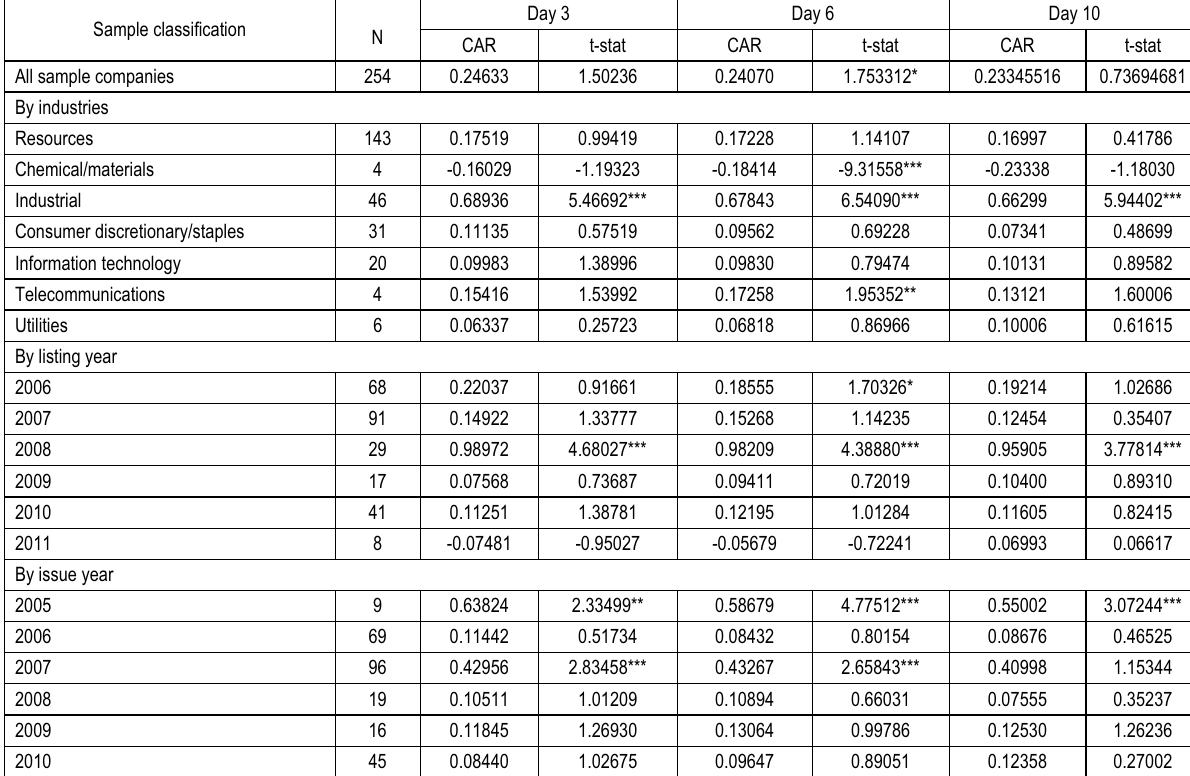
Fig. 1. The calculated average CARs for the nine post-listing days between 2006 and 2011 Table 4. Post-listing